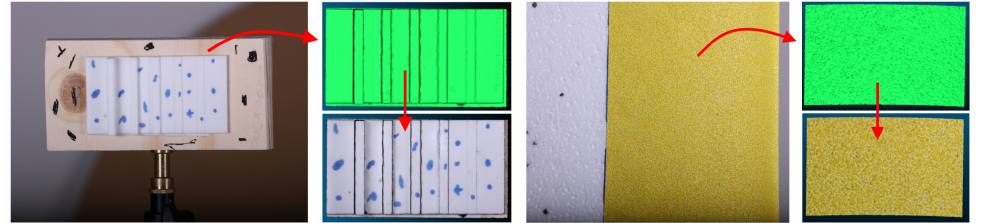
Figure 1. Step-height and sandpaper artifacts used in the paper as well as the reconstructed meshes and color